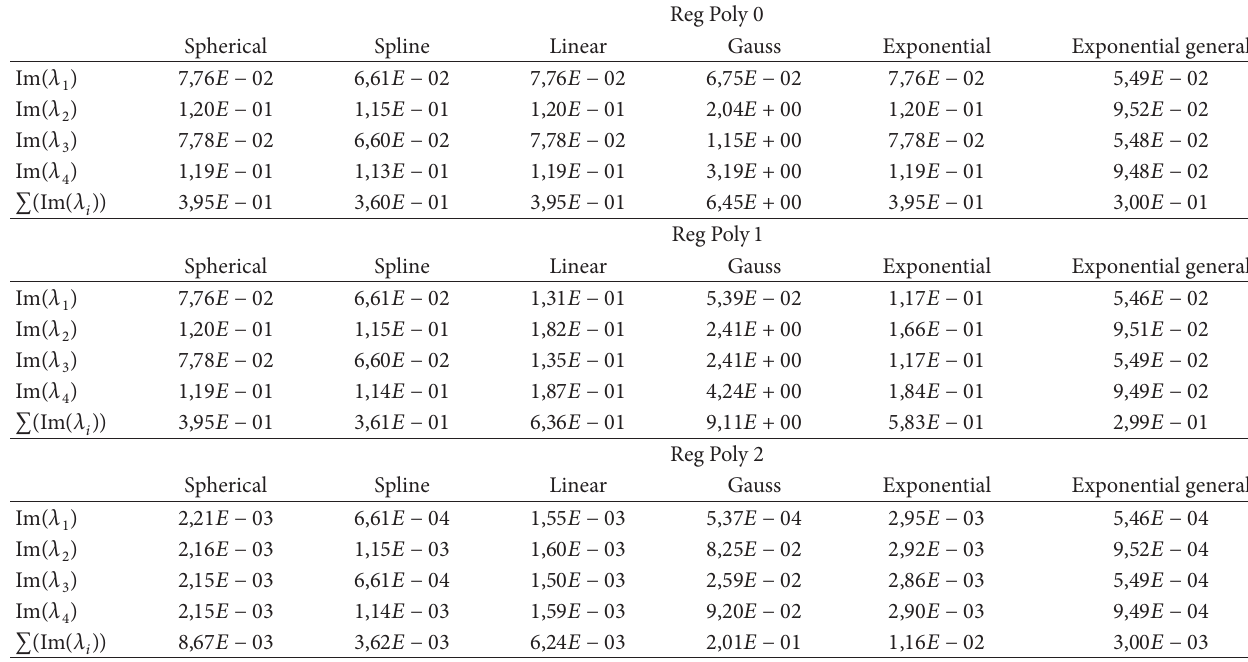
Table 5: Configuration 1: quadratic mean of absolute error on imaginary parts of eigenvalues for different regression and correlation kriging functions.